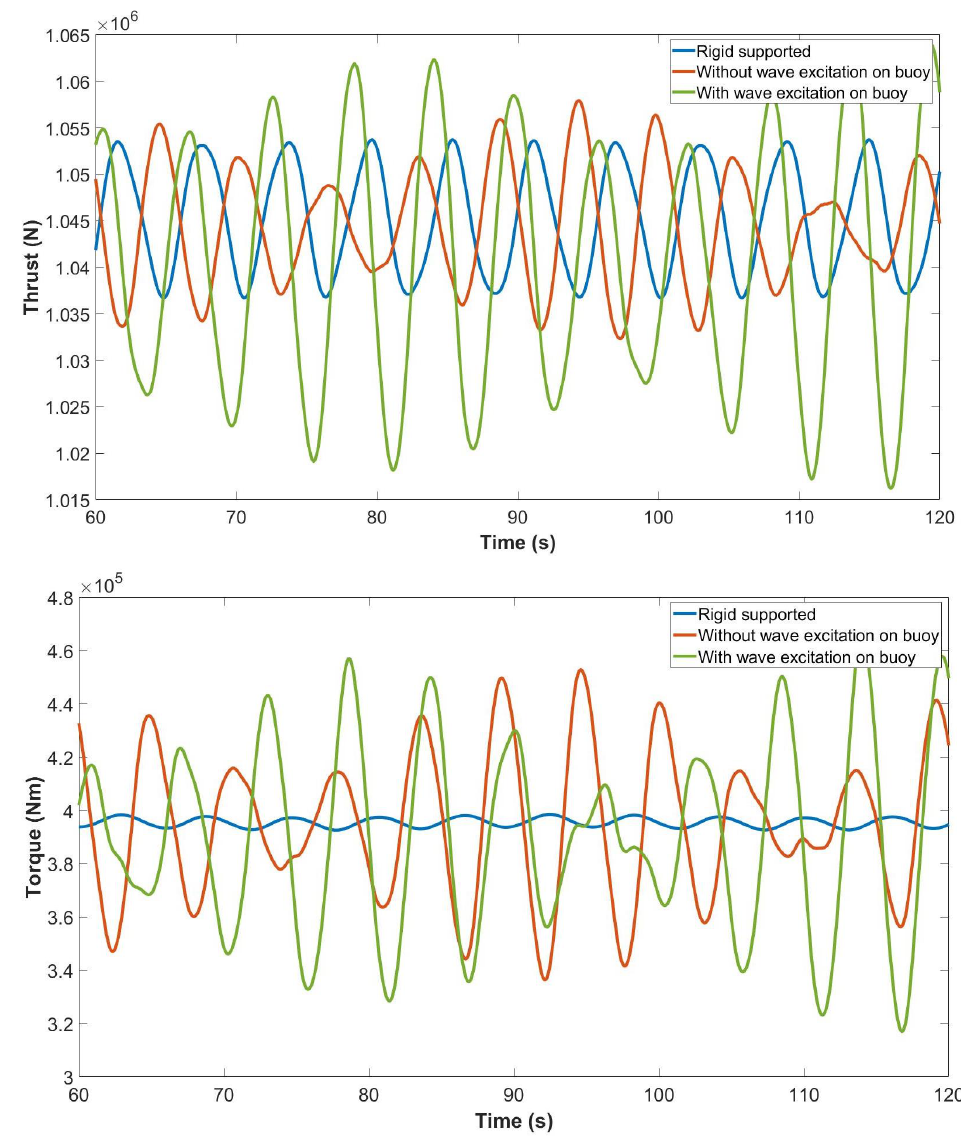
Figure 9. Thrust and torque in sea state